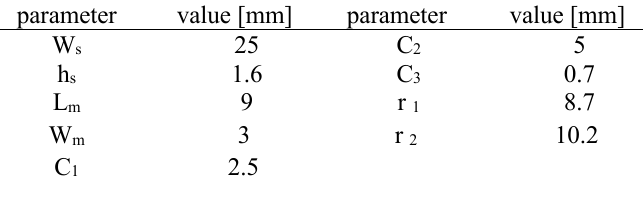
Table 1: Parameter values of the antenna